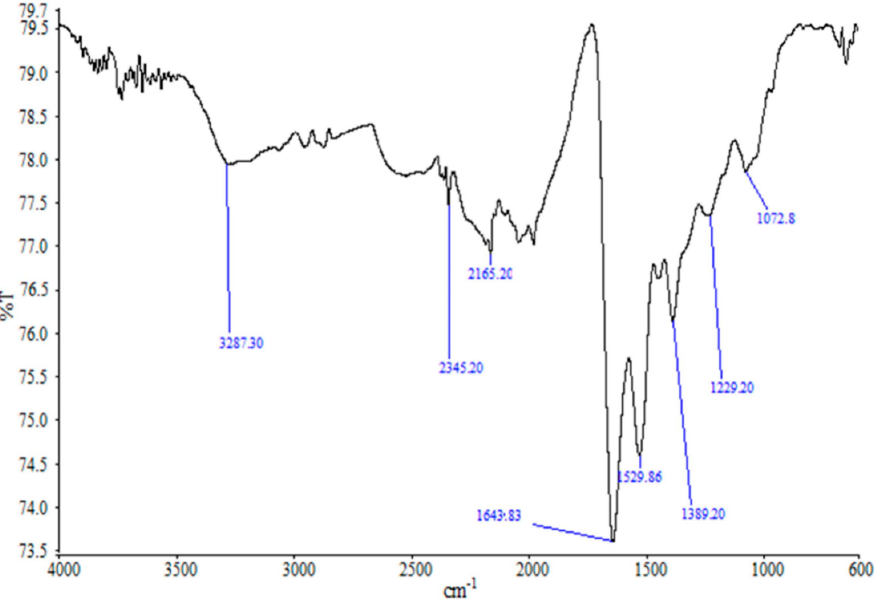
Figure 3. FTIR spectra of the synthesized AgNPs.